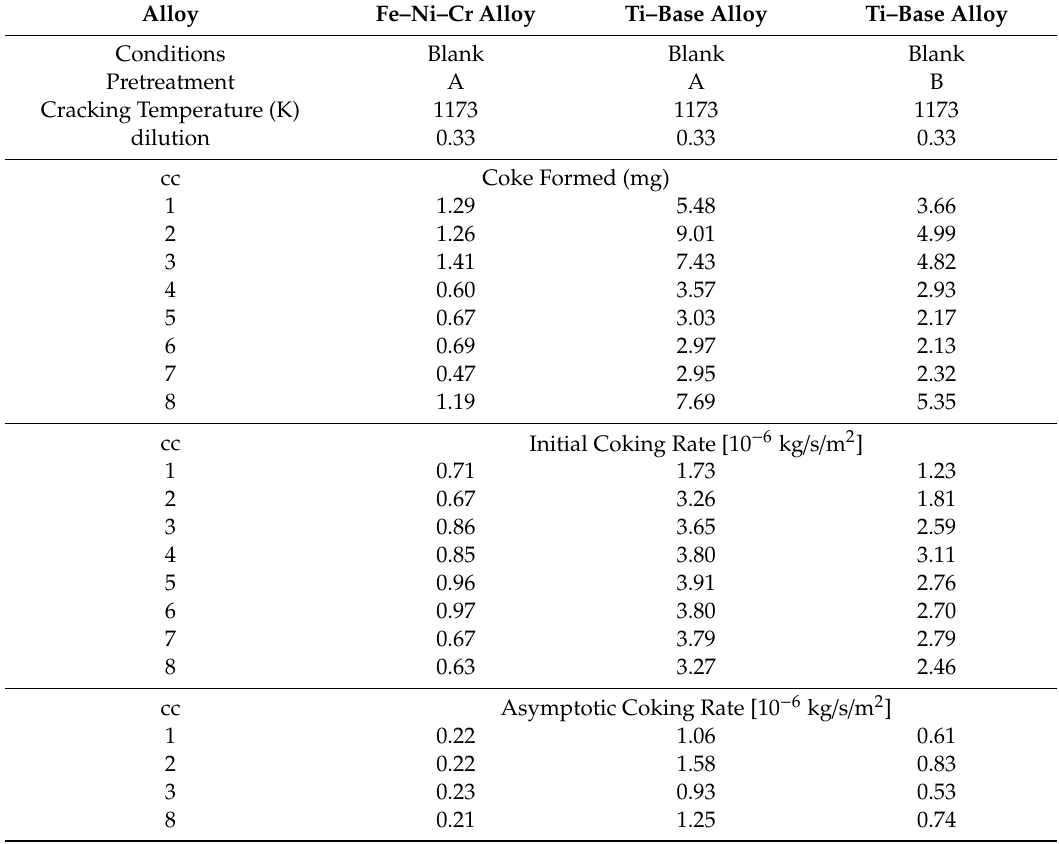
Table 4. Calculated initial (average 15–60 min) and asymptotic (average 5–6 h) coking rates. Alloy Fe–Ni–Cr Alloy Ti–Base Alloy Ti–Base Alloy Conditions Blank Blank Blank Pretreatment A A B Cracking Temperature (K) 1173 1173